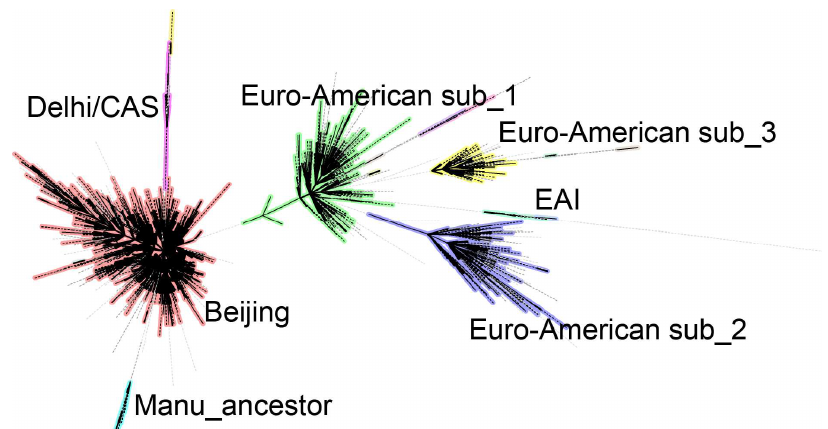
Fig 1. Minimum spanning tree based on 24 loci VNTR. Complexeswas definedby difference at 3 or less loci of the 24 VNTR pattern. Lineagename was assignedby comparingto MIRU-VNTRplus database, or by spoligotyping for Manu_ancestor